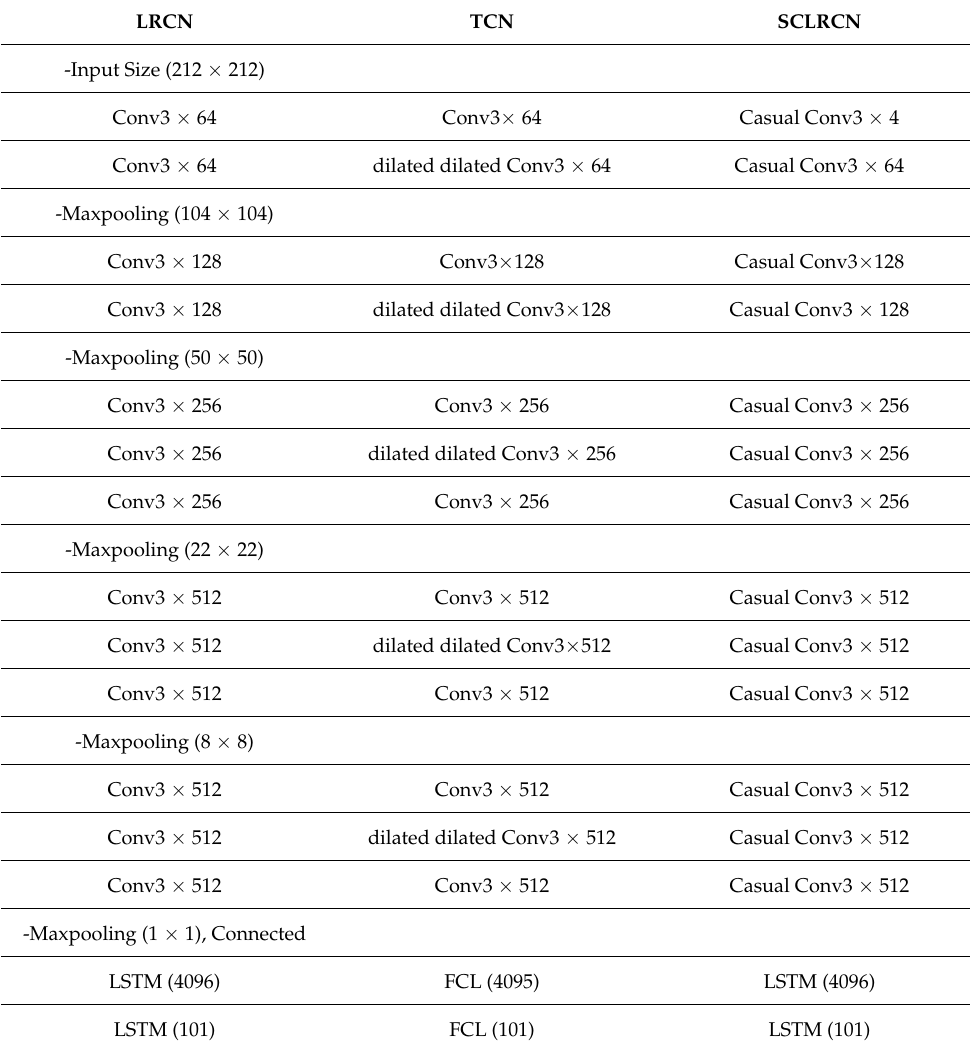
Table 2. Experimental neural network